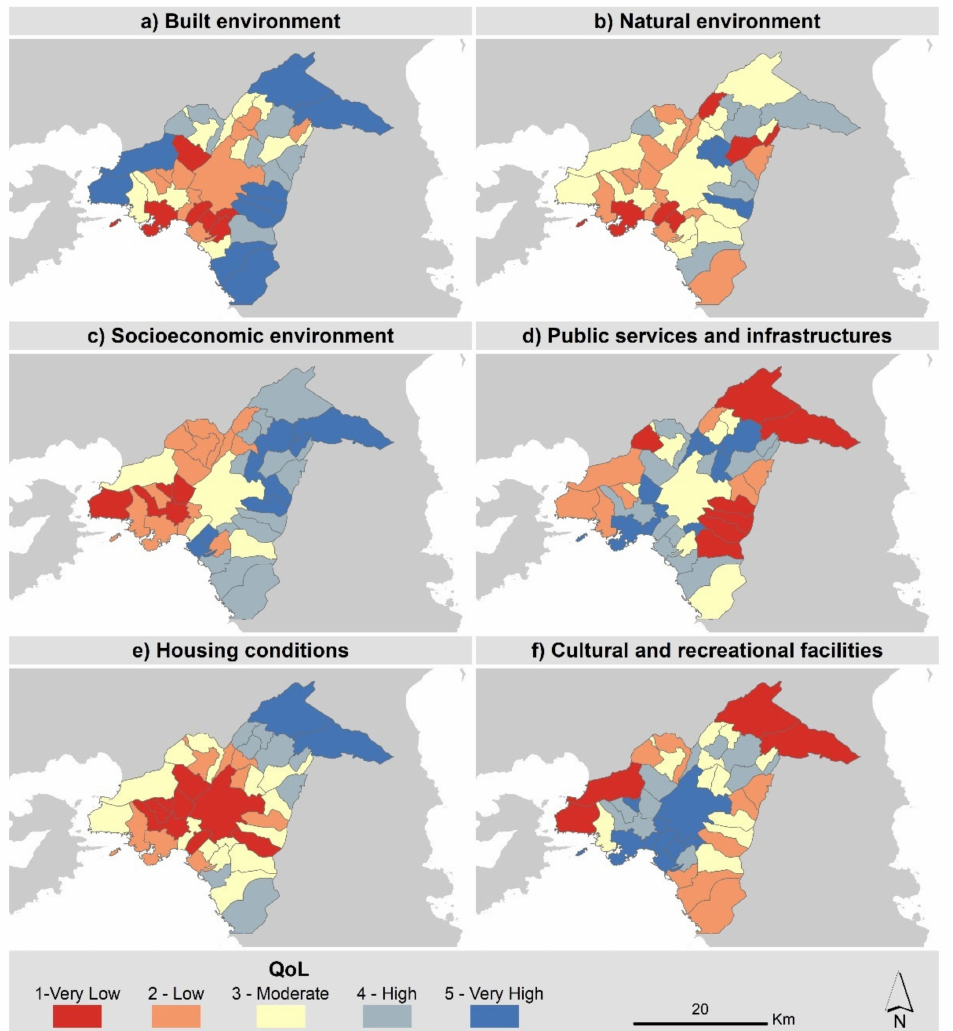
Figure 5. The composite criteria of QoL in AMA, Greece. ( a ) Built environment, ( b ) natural environ- ment, ( c ) socioeconomic environment, ( d ) public services and infrastructures, ( e ) housing conditions, ( f ) cultural and recreational